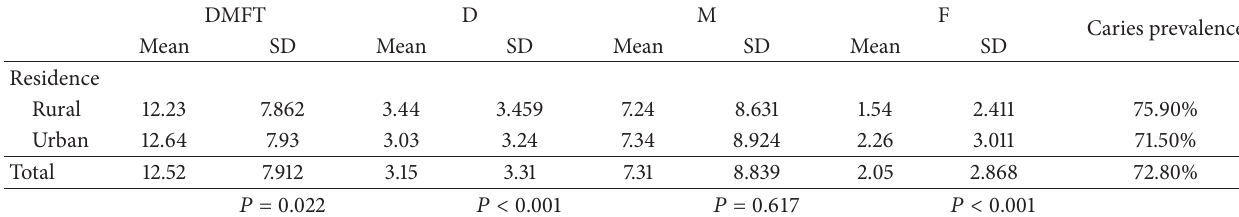
Table 4: DMFT, D, M, and F and caries prevalence according to